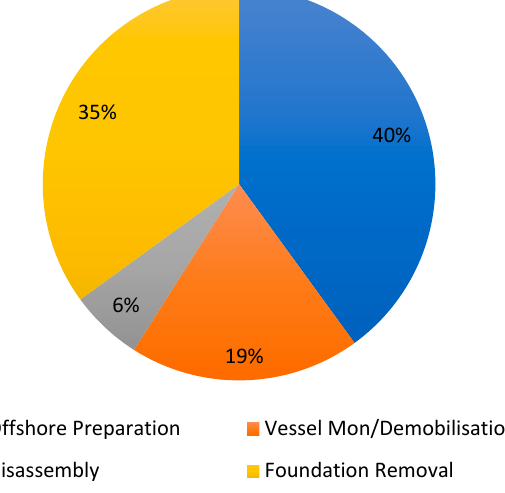
Figure 4. Decommissioning costs breakdown for bottom fixed offshore wind turbines [34].